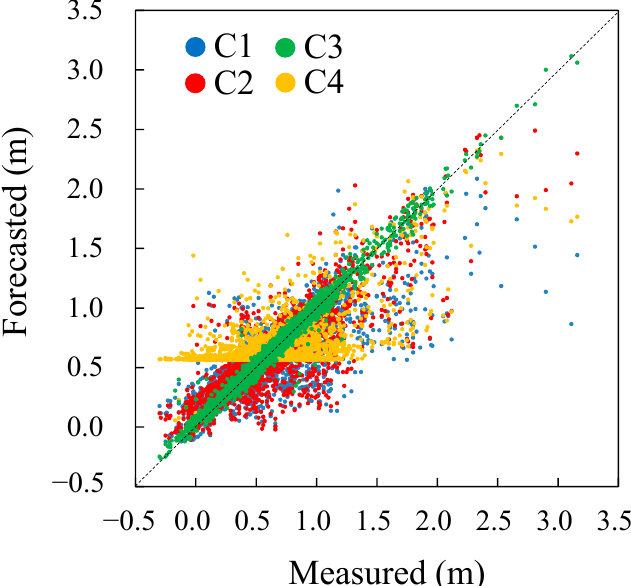
Figure 5. Scatter plot of measured and forecasted river stages in SVR model training with four combinations of inputs.